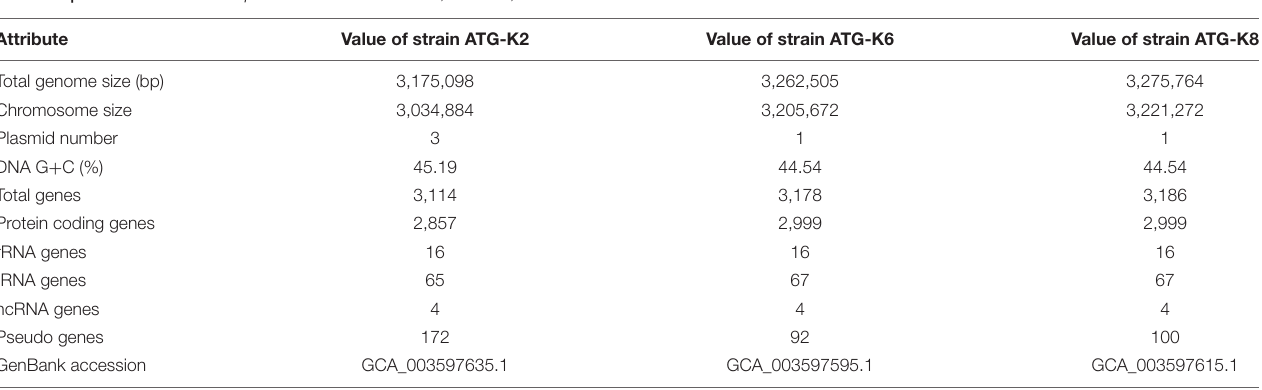
FIGURE 8 | Circular maps of (A) Lactobacillus plantarum ATG-K2, (B) L. plantarum ATG-K6, and (C) L. plantarum ATG-K8 complete genomes. TABLE 3 | General features of L. plantarum strains ATG-K2, ATG-K6, and